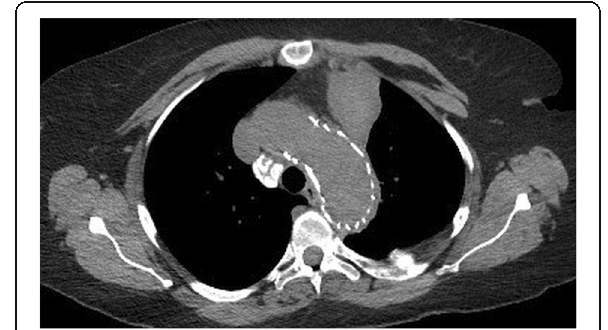
Fig. 4 Follow up CTA (axial view) one month after TEVAR showing an aortic stent graft and resolution of intramural